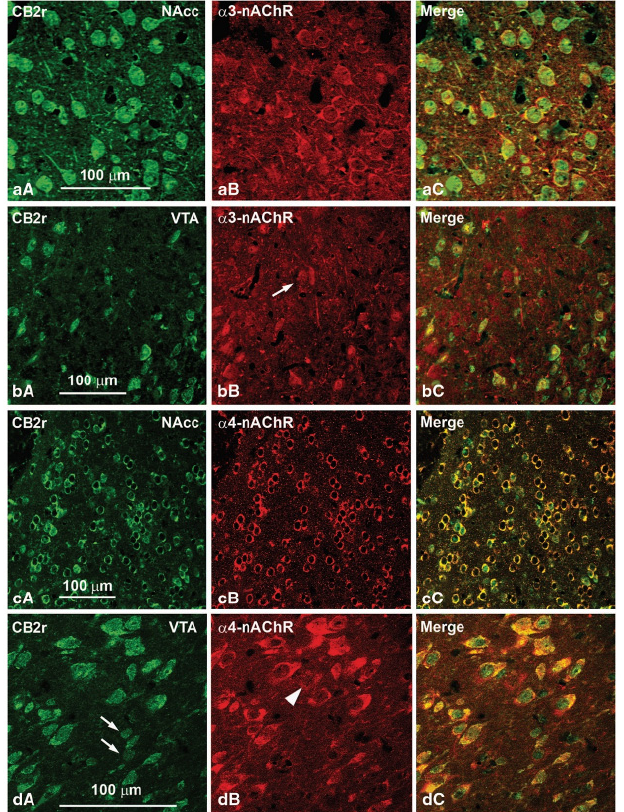
Figure 3. Confocal photomicrographs showing immunolabeling for CB2 receptors (CB2r) and α 3 and α 4 subunits of the cholinergic nicotinic receptor ( α 3-nAChR and α 4-nAChR) in the ventral tegmental area (VTA) and the nucleus accumbens (NAcc) of wild-type (WT) mice. Double labeling (yellow cells in panels aC, bC, cC and dC) indicates that α 3- and α 4-nAChRs colocalize with CB2r immunoreactive cells. Image adapted from Navarrete et al. Neuropsychopharmacology (2013) 38(12), 2515–2524. Furthermore, it is noteworthy that administering a CB2r agonist (O-1966) and a subef- fective dose of nicotine increased the stay in the drug-conditioned compartment. However, in this case, CB2-/- mice showed a similar response profile to WT mice when nicotine with- drawal syndrome was pharmacologically precipitated by mecamylamine